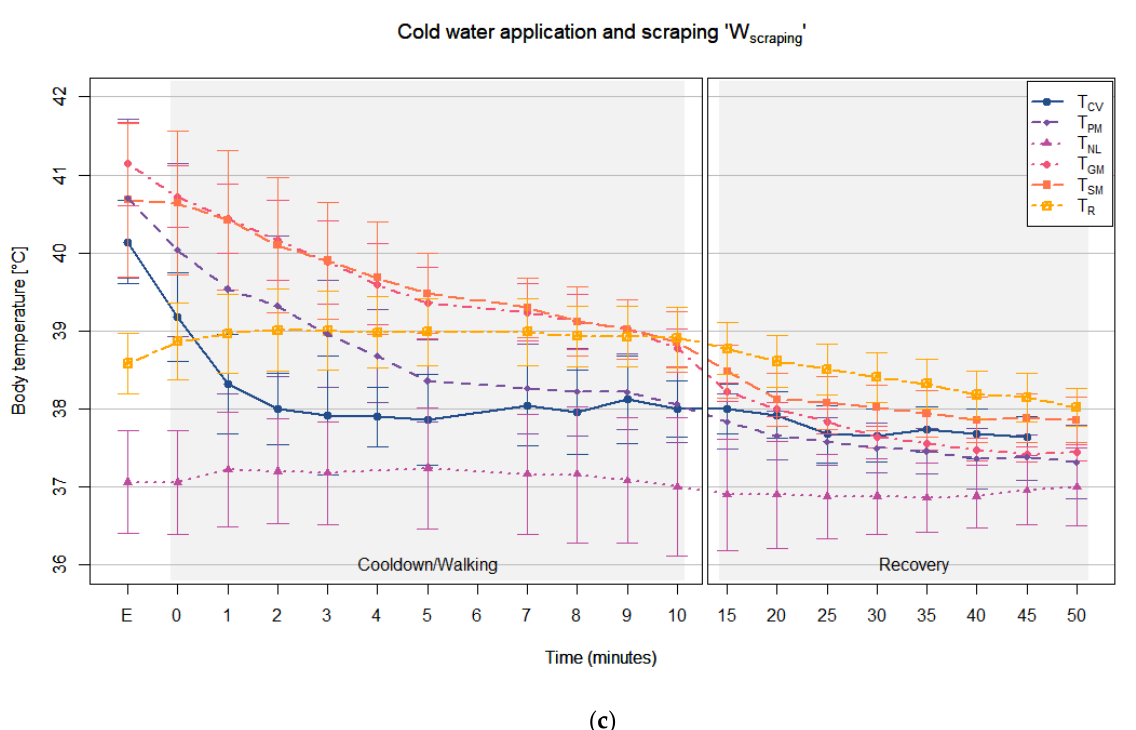
Figure 4. The PTSM temperatures post-exercise during each of the three cool-down methods, ( a ) no water application (continuously walking), ( b ) cold water application only, and ( c ) cold water application and scraping. Abbreviations: E = end of treadmill exercise, T CV = central venous temperature, T PM = pectoral muscle temperature, T NL = nuchal ligament temperature, T GM = gluteal muscle temperature, T SM = splenius muscle temperature, T R = rectal temperature.